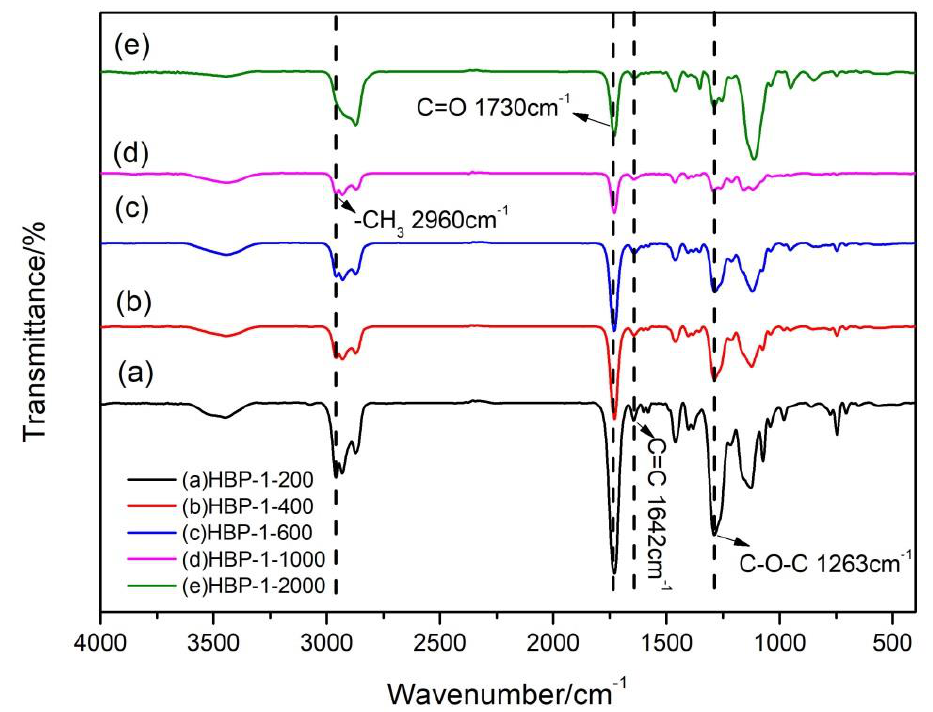
Figure 2. FTIR spectra of HBP-1-200, HBP-1-400, HBP-1-600, HBP-1-1000 and HBP-1-2000.